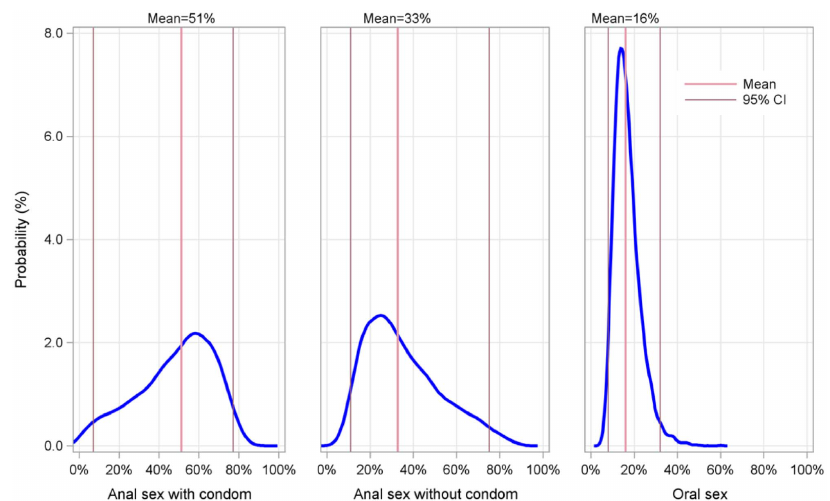
Figure 1. Modeled distribution of fraction of new infections due to each sexual practice, with mean and 95 percent confidence